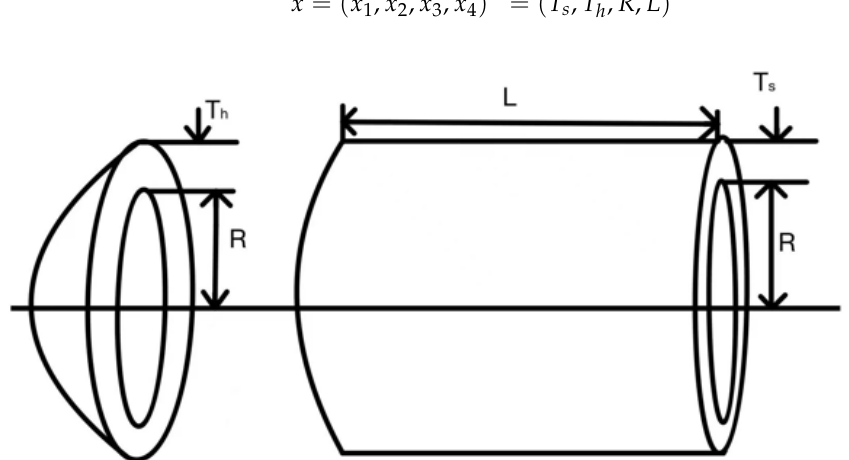
Figure 3. Pressure vessel structure diagram.